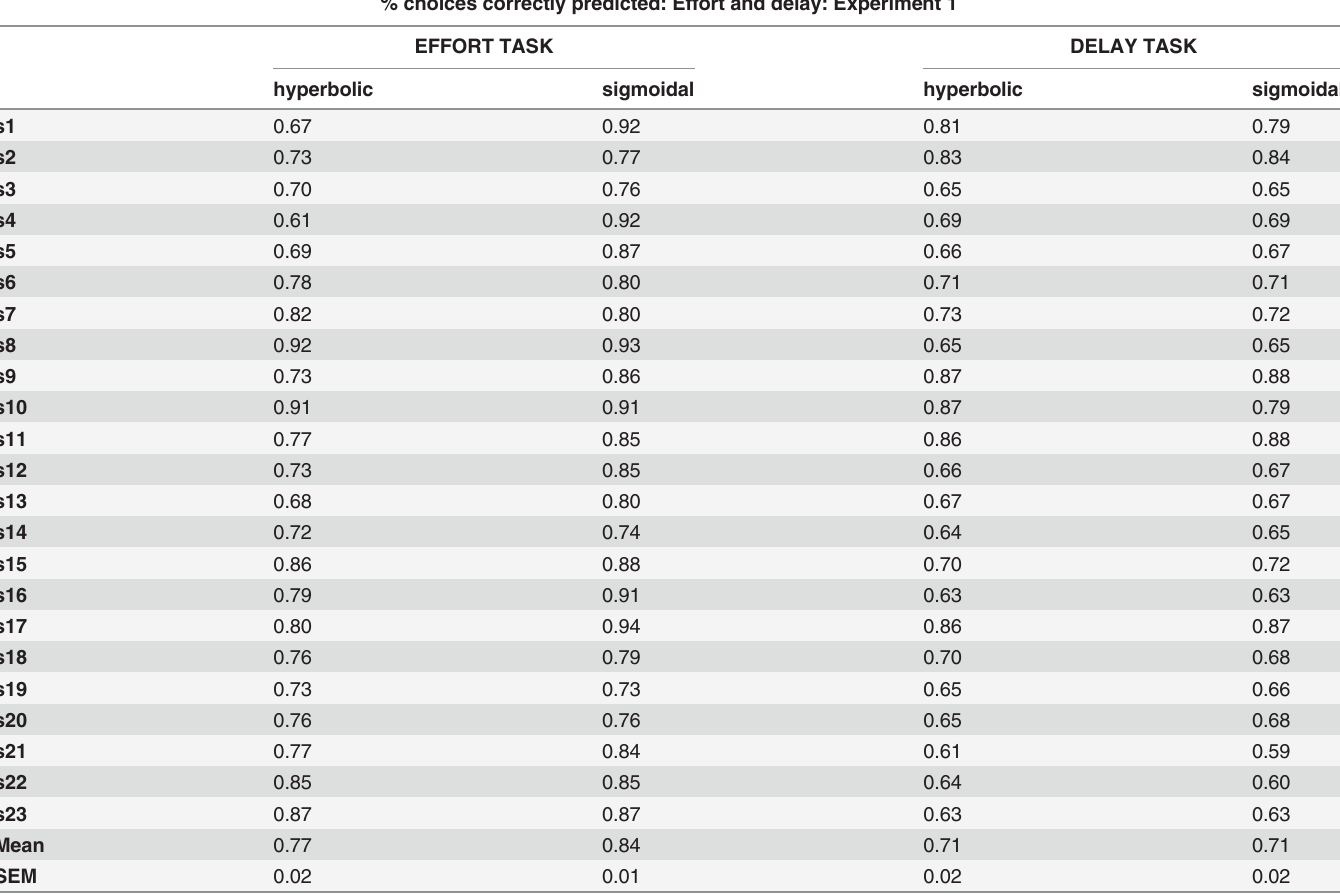
Table 1. Choices explained by the model (Experiment 1). % choices correctly predicted: Effort and delay: Experiment 1